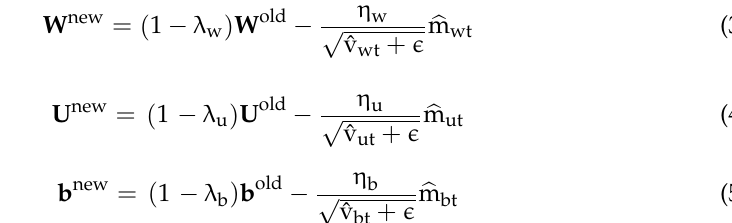
Table 1. 31 positions with nine di ff erent indexations of balls 1, 2, 3, and 4.